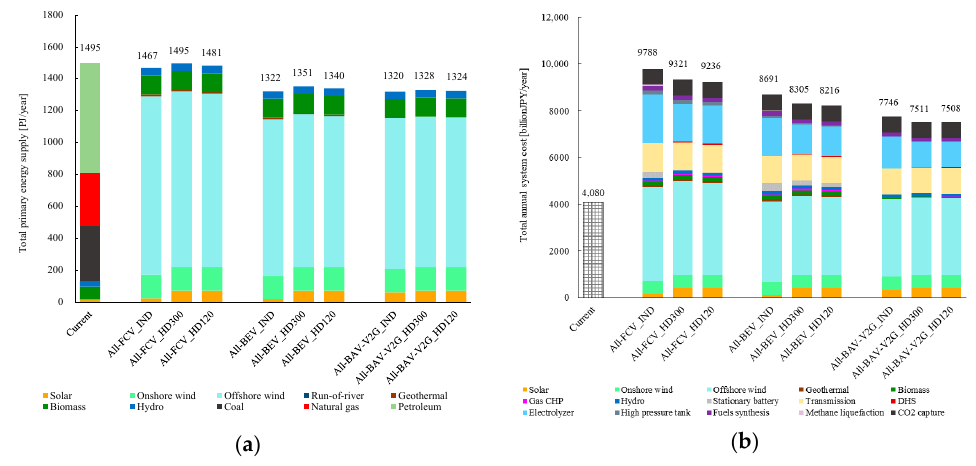
Figure 3. Comparison of system performance in each scenario. ( a ) TPES. ( b ) Total annual system cost.